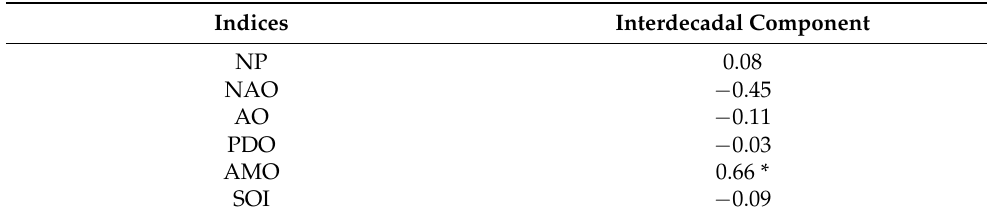
Table 1. Correlation coefficients between various indices and NECVHR for interdecadal component. * Significant value at the 95% confidence level. Southern oscillation index (SOI), Atlantic multidecadal oscillation (AMO), Arctic oscillation index (AO), North Pacific index (NP), North Atlantic oscillation (NAO), and Pacific decadal oscillation (PDO).